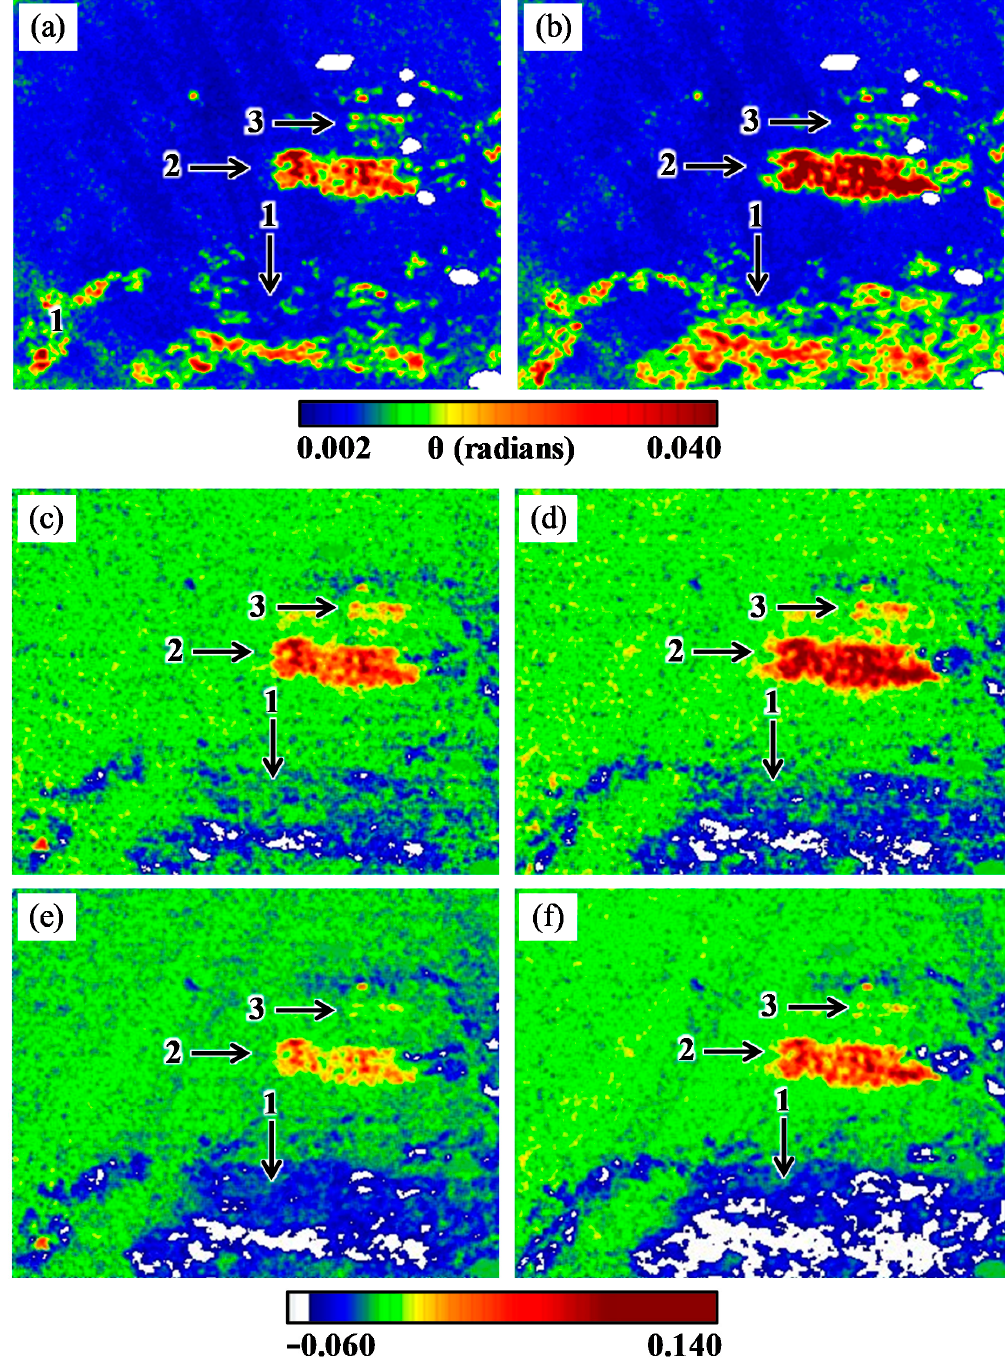
Figure 7. SAM algorithm rule map ( a ), ∆ SQCMI image ( c ) and ∆ SCI image ( e ) of the loess soil study area emphasizing changes on the surface resulting from the dispersion of 100 g m − 2 dust_2 (region 1), 100 g m − 2 dune sand (region 2) and 50 g m − 2 dune sand (region 3). SAM algorithm rule map ( b ), ∆ SQCMI image ( d ) and ∆ SCI image ( f ) resulting from the dispersion of 250 g m − 2 dust_2 (region 1), 250 g m − 2 dune sand (region 2) and 50 g m − 2 dune sand (region 3); green color in ( c )–( f ) represents ∆ SQCMI and ∆ SCI ≈ 0, i.e., no mineralogical changes.